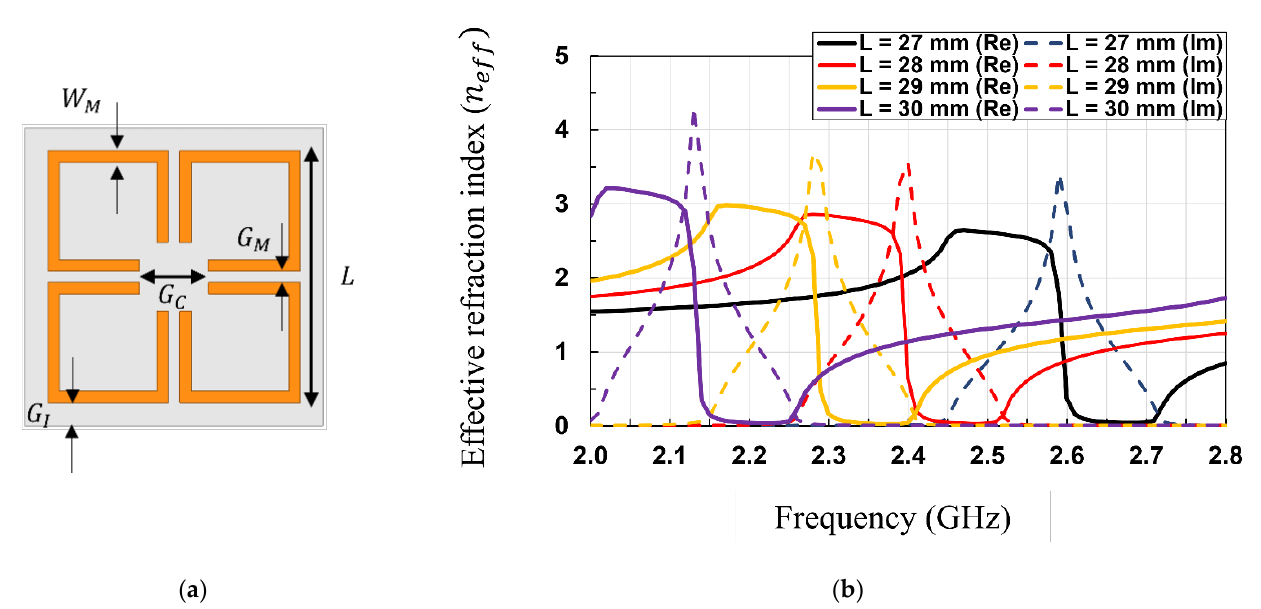
Figure 3. ( a ) Schematic of the 4-leaf clover shaped MTM unit cell; ( b ) Simulated effective refraction index of the MTM unit cell with the varied 𝐿 values ( 𝐿 = 28 mm,𝑊 𝑀 = 1 mm,𝐺 𝑀 = 1 mm,𝐺 𝐶 = 6 mm,𝐺 𝐼 = 2 mm ).